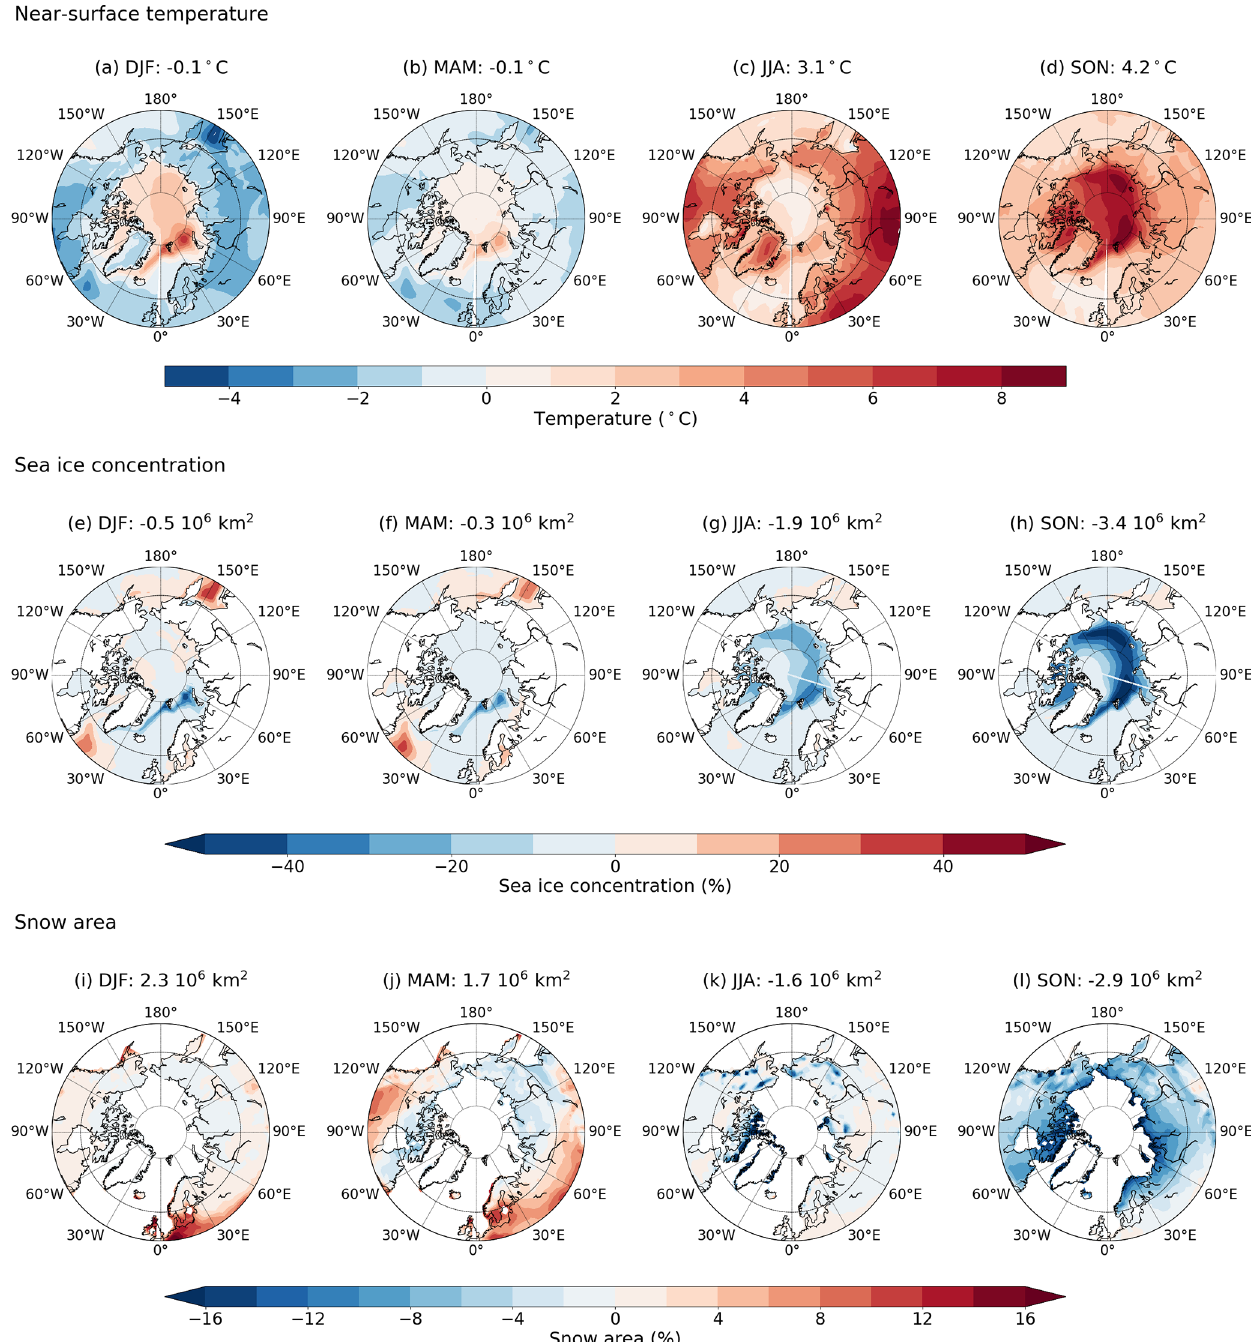
Figure 7. Seasonal cycles of the near-surface air temperature (a–d) , sea ice concentration (e–h) and snow cover (i–l) LIG–PI anomalies. The value mentioned above the maps is the spatial average of the three variables over the Arctic region (60–90 ◦ N). Seasons are